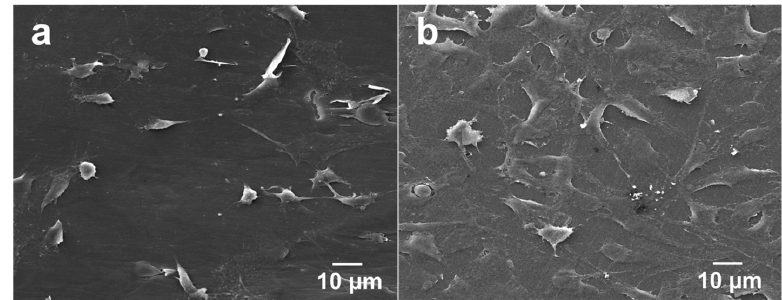
Figure 10. SEM images of PEEK/(1.88% MWNT) nanocomposite cultured with osteoblasts for ( a ) 2 and